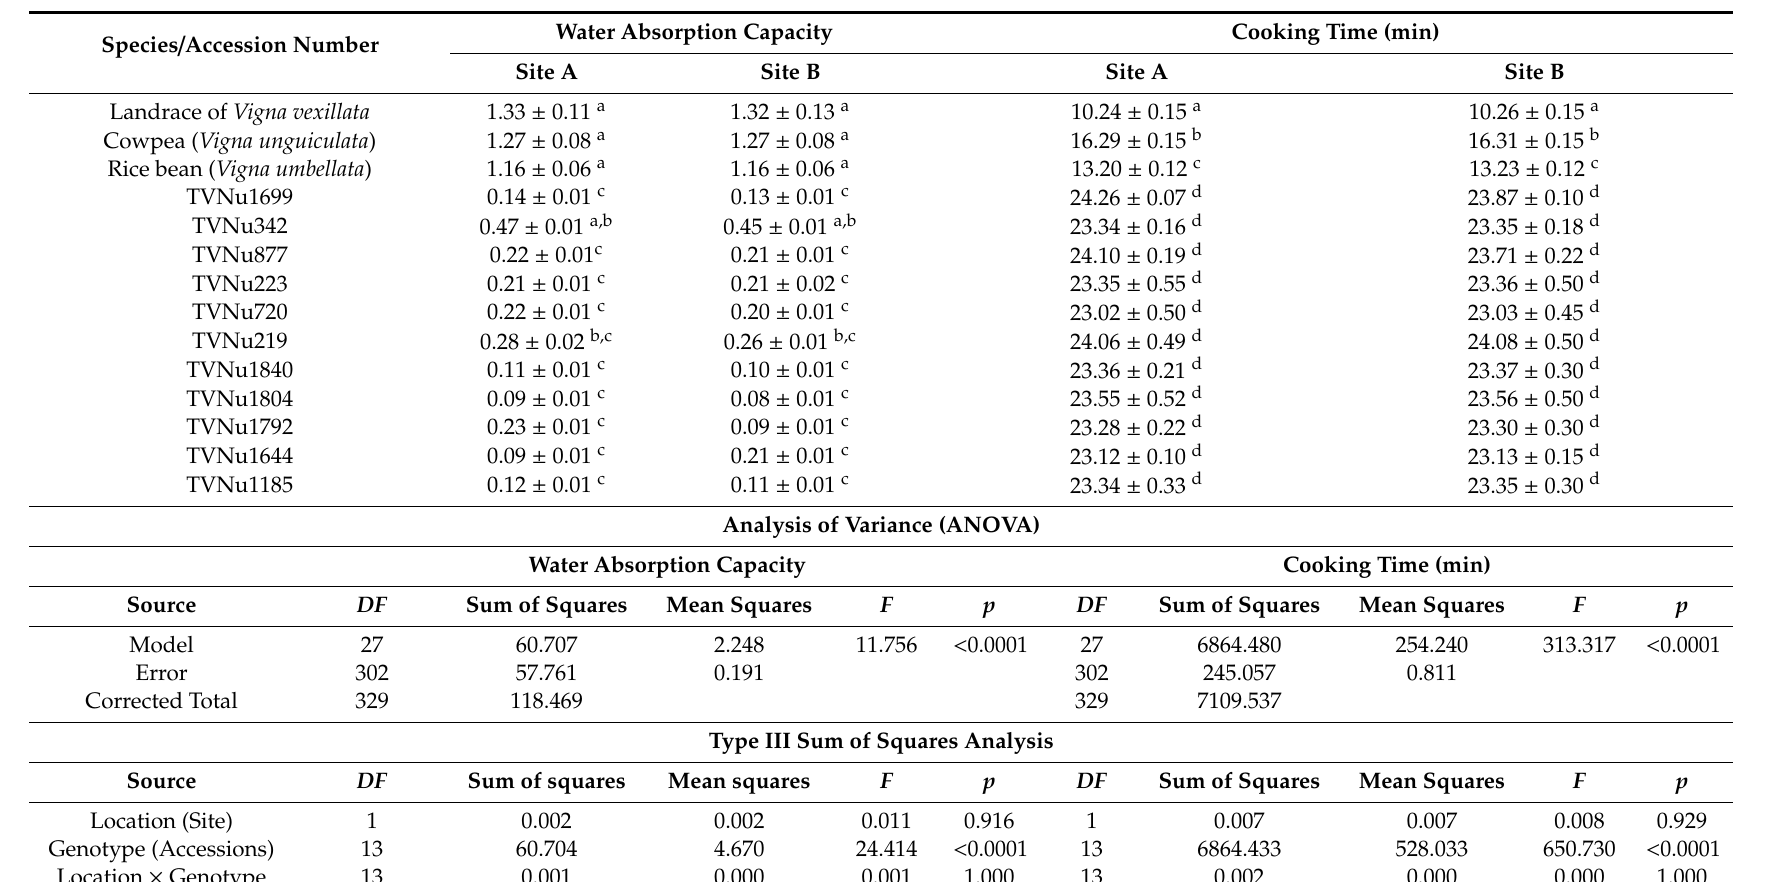
Table 3. Cooking time and water absorption of Vigna ambacensis